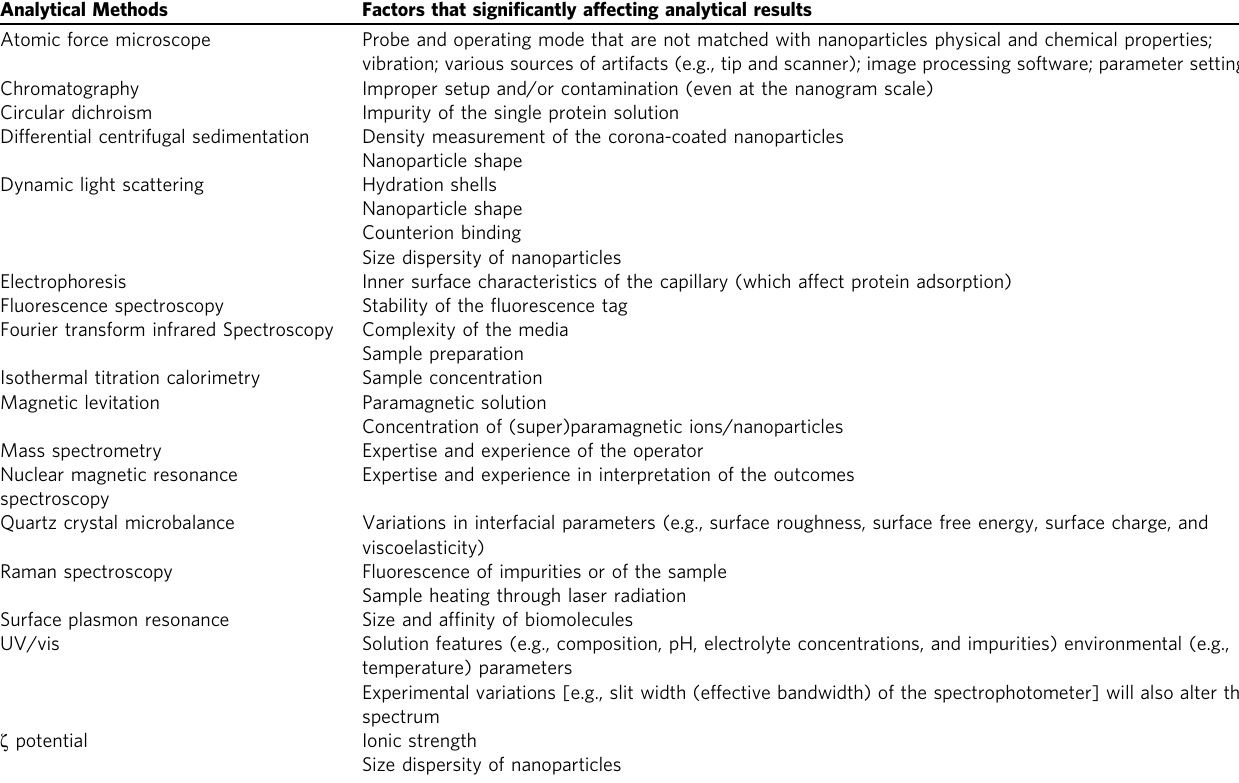
Table 1 List of the common analytical methods used to study the nanobio interface and related factors that can signi fi cantly affect their outcomes (details of each method can be found in refs. 14,24